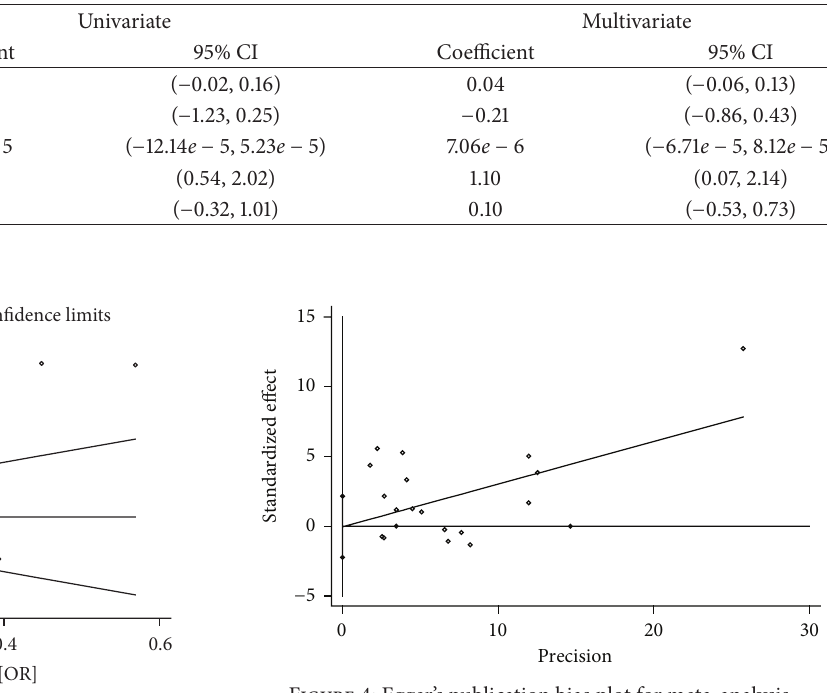
Figure 3: Begg’s funnel plot for meta-analysis.